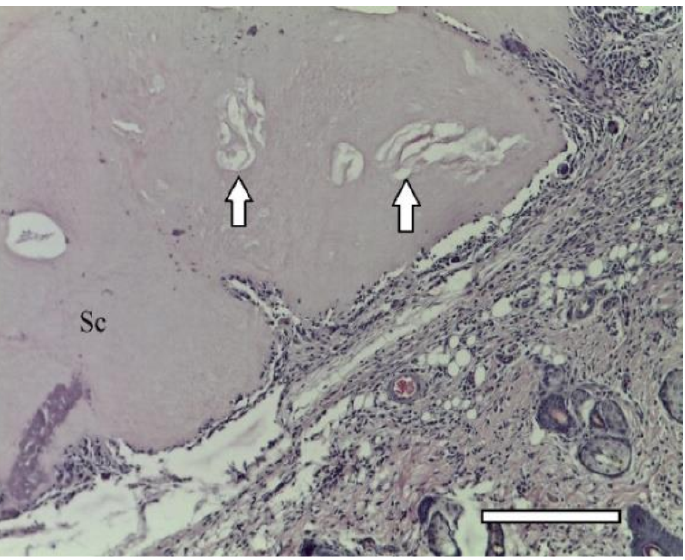
Figure 6. 1st group (dECM only), 1 week. A connective tissue capsule surrounding the scaffold (Sc). Staining with hematoxylin and eosin, objective lens × 10, scale bar—200 µ m. Cavities filled with fibrillar material are shown by arrows.